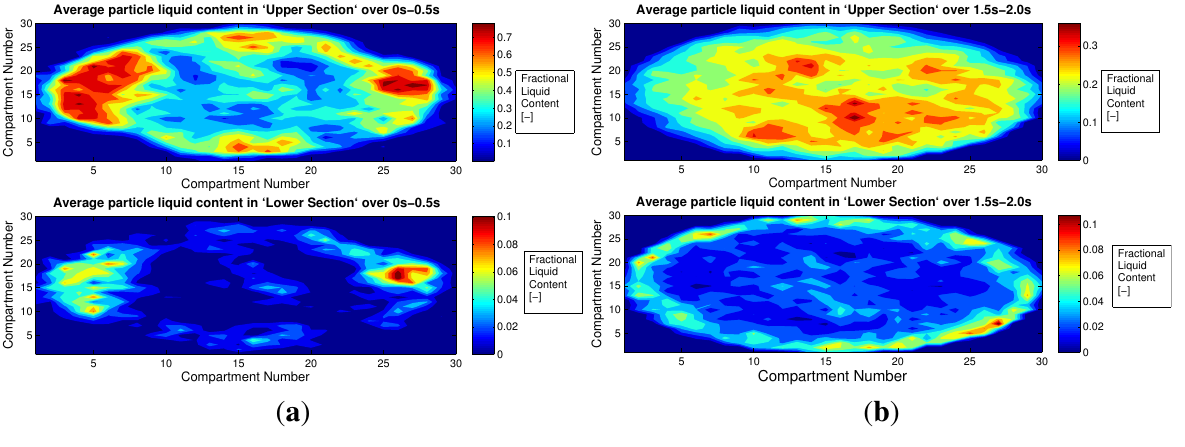
Figure 4. Plots for particle liquid content distribution. ( a ) Liquid content over 0 s–0.5 s; ( b ) Liquid content over 1.5 s–2.0